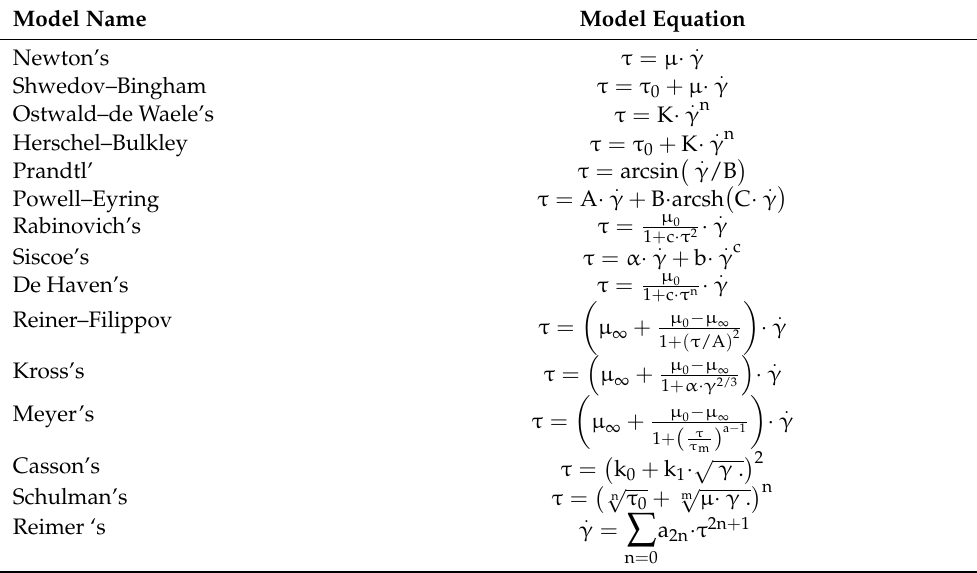
Table 2. Rheological models of non-linear viscous media